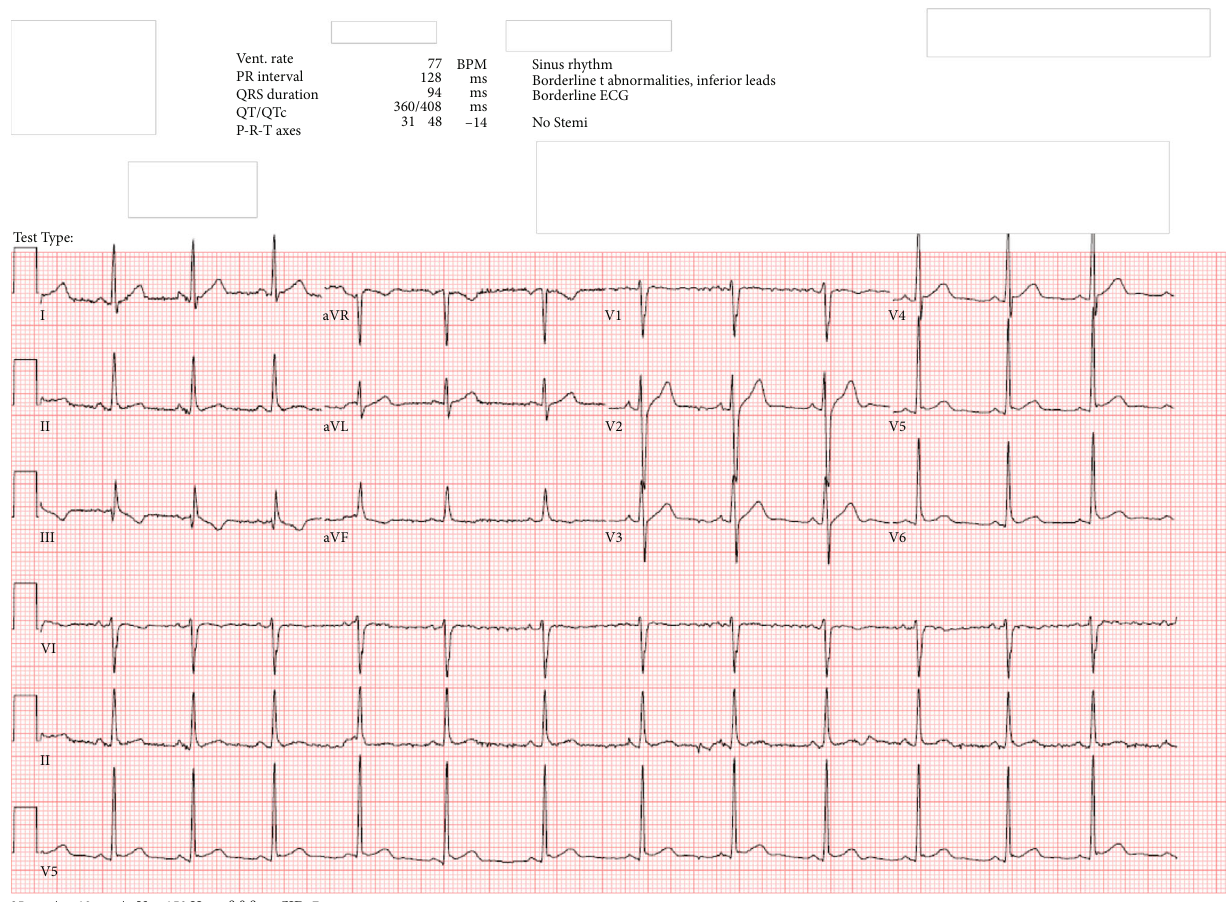
Figure 1: EKG from hospital day